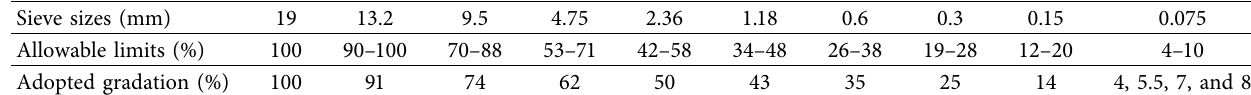
Table 2: Adopted gradation of asphalt concrete